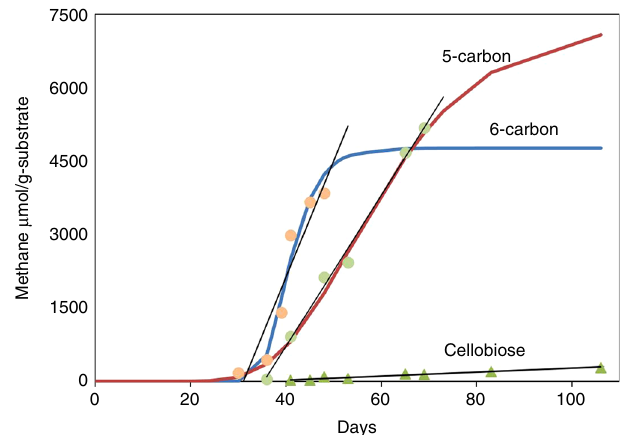
Fig. 5 Linear methane rates and Gompertz model production curves of monosaccharides and disaccharides. The blue curve is the averaged six-carbon carbohydrates and the red curve is the averaged fi ve-carbon carbohydrate treatments. The black line with green triangle data points represents the cellobiose